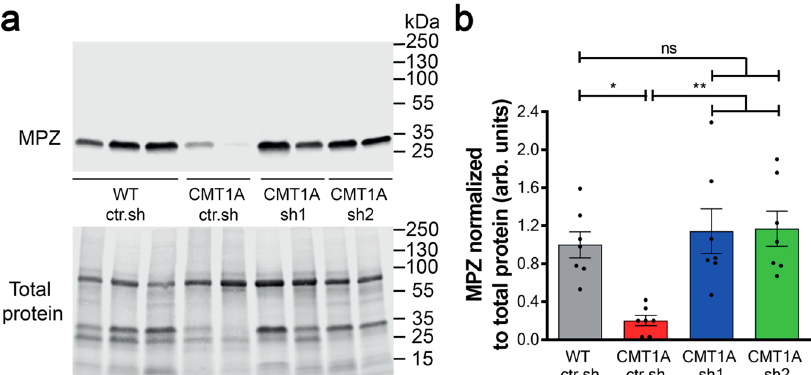
Fig. 3 Intra-nerve injections of AAV2/9-sh1 and -sh2 in CMT1A rats normalize MPZ expression back to WT rat level. a Representative images of Western blot showing MPZ protein levels (upper panel) and total protein as loading control (lower panel) in sciatic nerve lysates from WT ctr.sh, CMT1A ctr.sh, CMT1A sh1 or CMT1A sh2 three months after injection. b Graph shows mean MPZ level in sciatic nerve lysates normalized to total protein level loaded as loading control ( n = 7 animals per group). Statistical test shows one-way ANOVA followed by Tukey ’ s post hoc, two-sided. * p = 0.0122 between WT ctr.sh and CMT1A ctr.sh, ** p = 0.0028 between CMT1A ctr.sh and CMT1A sh1, ** p = 0.0022 between CMT1A ctr.sh and CMT1A sh2; ns,